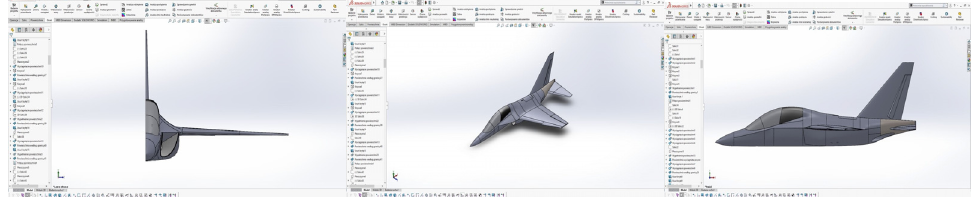
Figure 6. Front, left and top views of the M-346 aircraft model in SolidWorks.